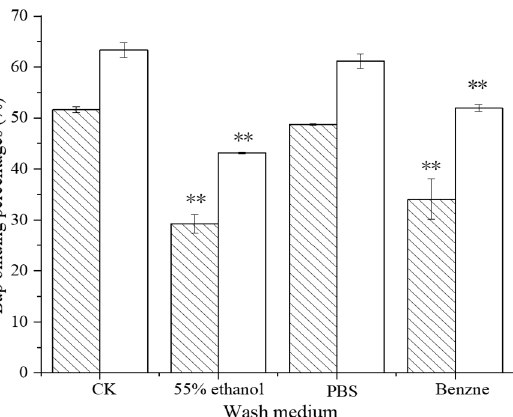
Figure 2. The stability of the binding of Lactobacillus –BSA to BaP. Note: ** p < 0.01. 121 and ML32.